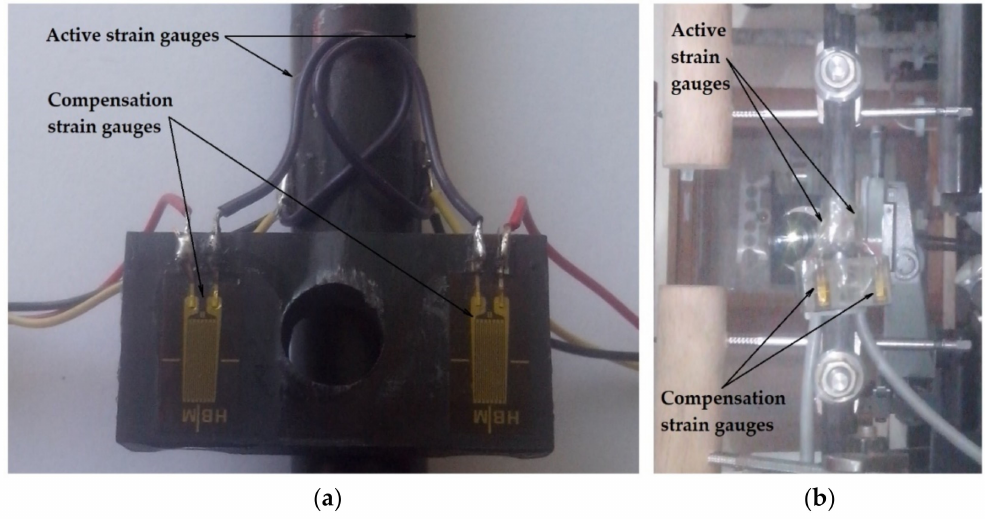
Figure 7. Strain gauges arrangement; ( a ) mounting, ( b )